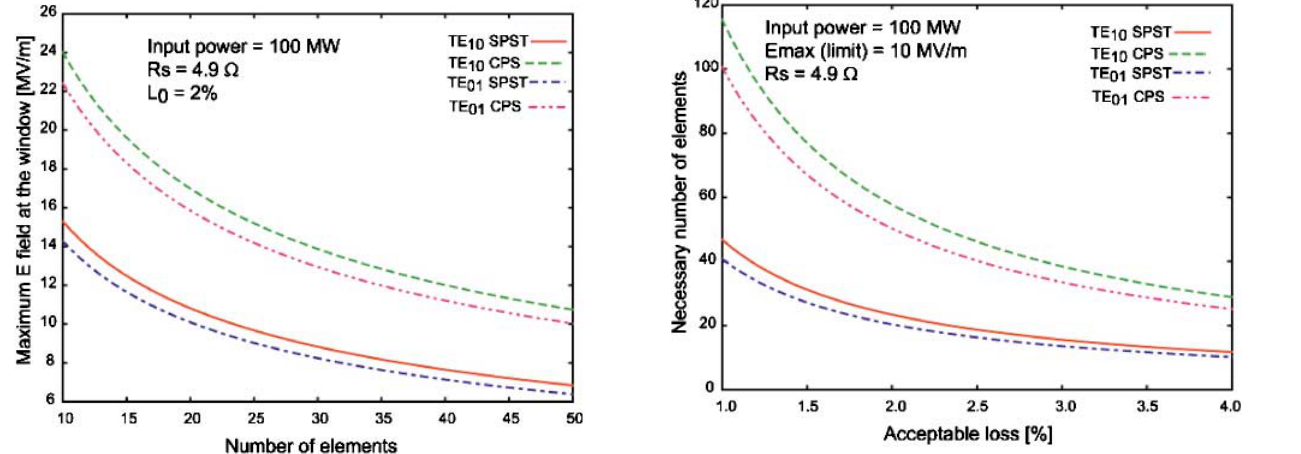
FIG. 6. (Color) Number of elements versus maximum electric field of the active window.